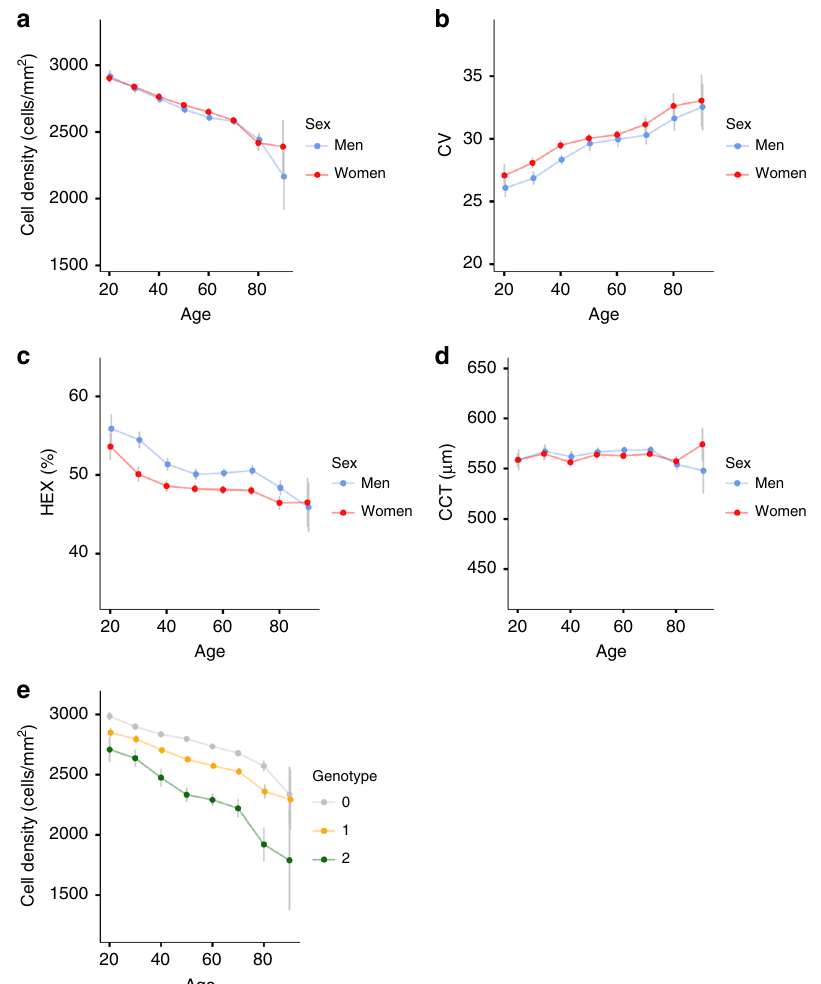
Fig. 1 Corneal structure measurements by age ( N = 6125). The average a cell density, b HEX, c CV, and d CCT values for subjects belonging to a 10 year age group (e.g., age = 30 for individuals between 26 and 35) against age, for men and women. e The average cell density for subjects belonging to a 10 year age group against age for noncarriers, heterozygous, and homozygous carriers of the ANAPC1 variant, rs78658973. The gray lines show the 95% con fi dence